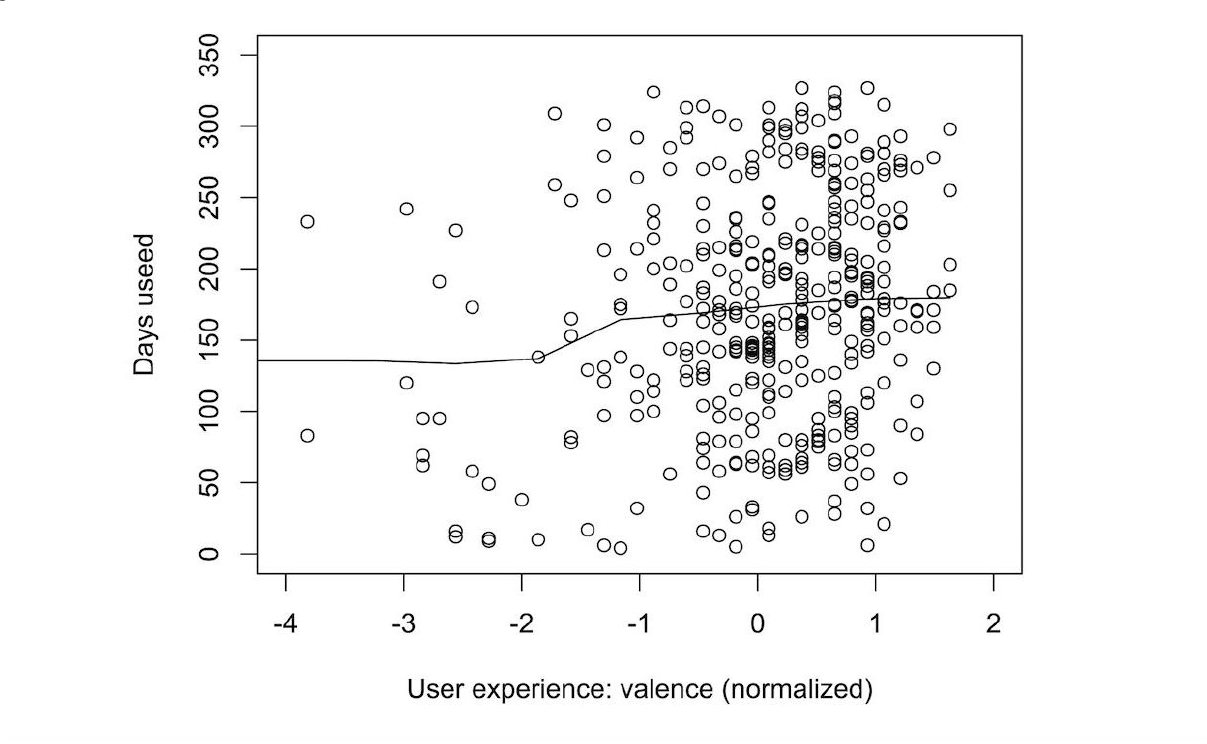
Figure 14. Plot of the partial dependence of sustained tracker use on user experience of the valence of the tracker. A better user experience leads to longer sustained use.